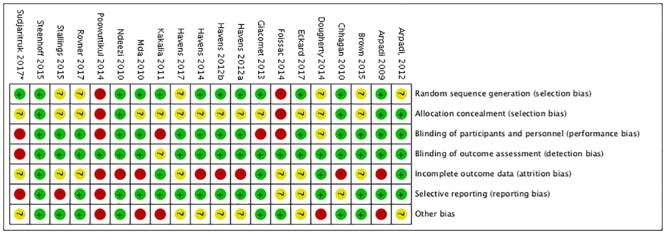
Reviewer assessed risk of bias per Cochrane collaboration domain.High [red], unclear [yellow], and low [green] {Source: created using Review Manager 5.3 [49]}. *Based on avaible data from published abstract, abstract oral presentation, and clinical trials.gov protocol.